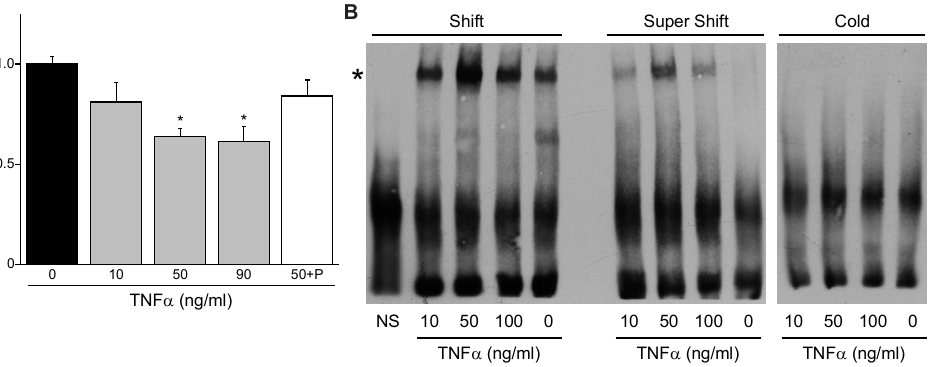
Figure 5. TNFα represses PGC-1α expression and increases NF-κB p65 binding to the proximal M2 site in the PGC-1α promoter. ( A ) Dose-dependent repression of PGC-1α mRNA expression by TNFα, with attenuation by parthenolide, in post-natal rat cardiac myocytes. * p < 0.05 versus 0 TNFα treatment. ( B ) Electrophoretic mobility shift assay for p65 binding to the PGC-1α promoter proximal M2 site in response to TNFα. *, shifted protein–oligonucleotide complex. NS, non-shifted control lacking cell lysate.